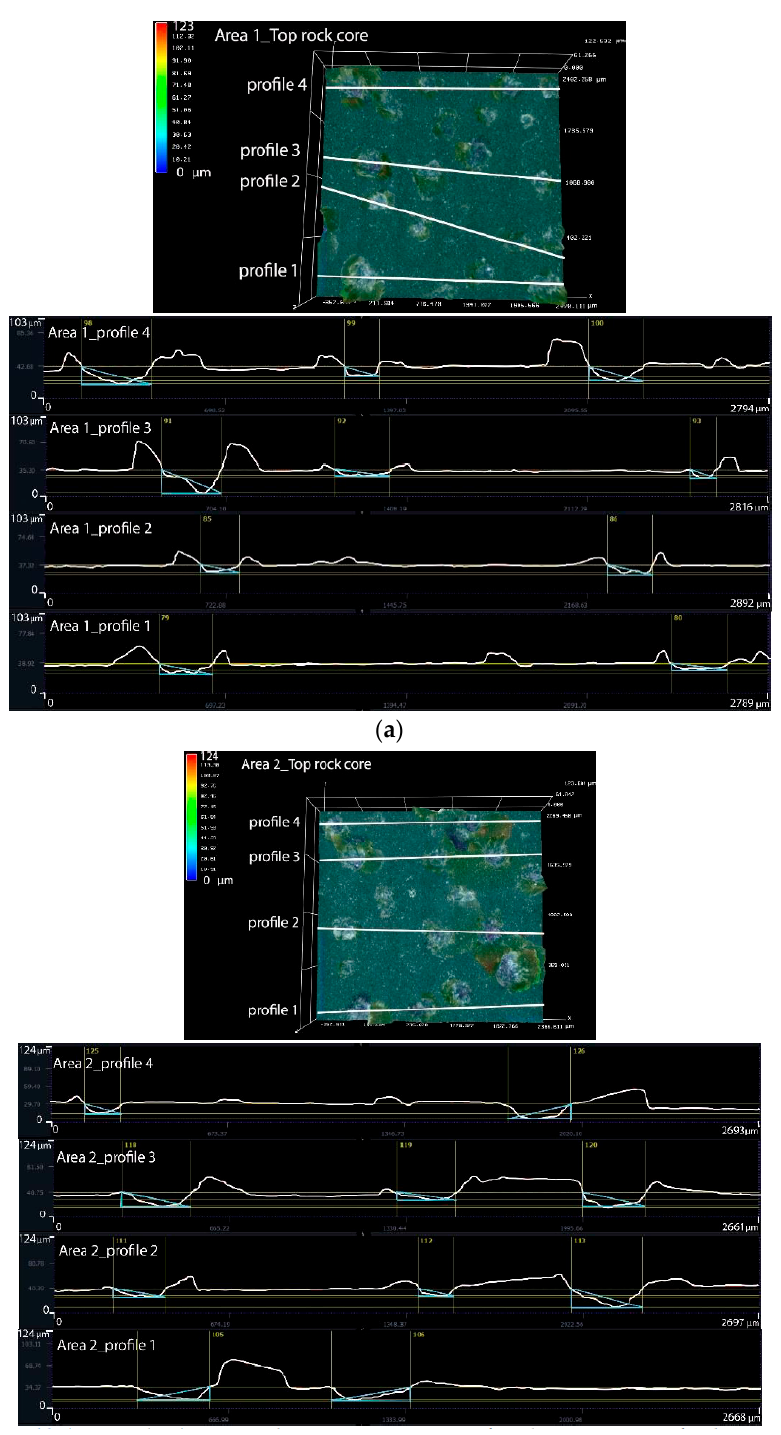
Figure 12. Average depth H e plug (Test 1): ( a ) Area 1; ( b ) Area 2.